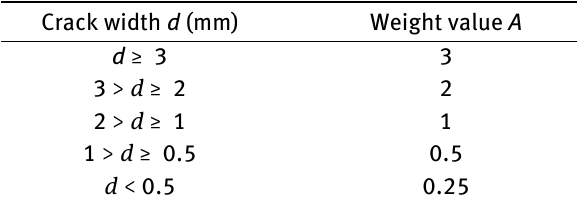
Table 5: Weight value for crack width Crack width d (mm) Weight value